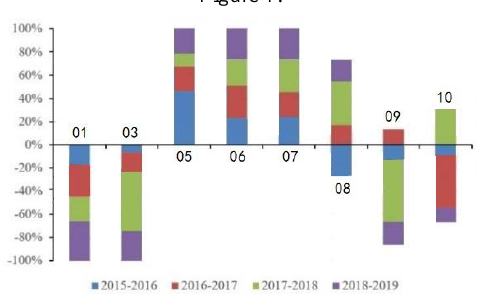
Figure 6 . Coastal landscape development intensity in